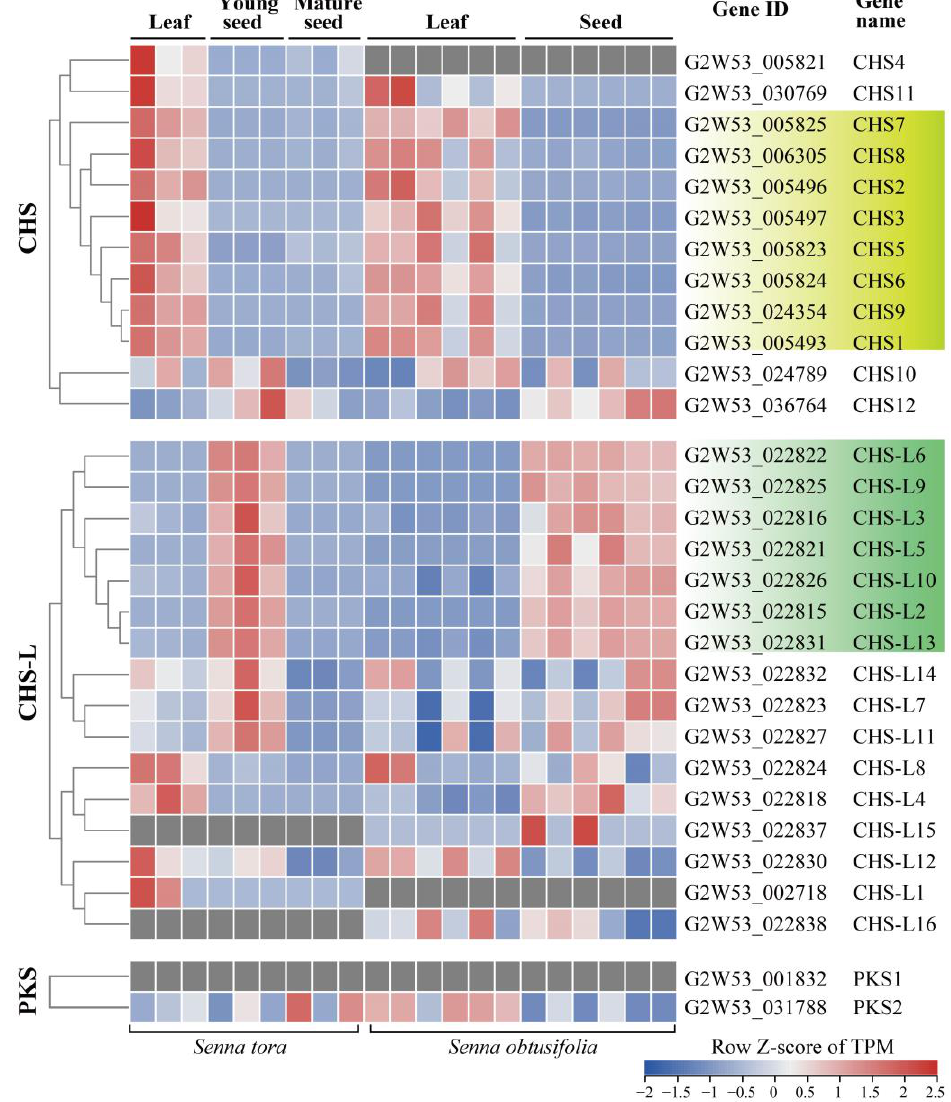
Figure 5. The expression profiles of the type III PKS genes in the Senna tora and Senna obtusifolia leaves and seeds. The relative expression levels of transcripts per million (TPM) were calculated from the transcriptome data (accession number SRP159435 and SRP144670). The color scale at the bottom right represents the TPM normalized by the row Z-score. The relatively low and high expression levels are indicated by blue and red, respectively.